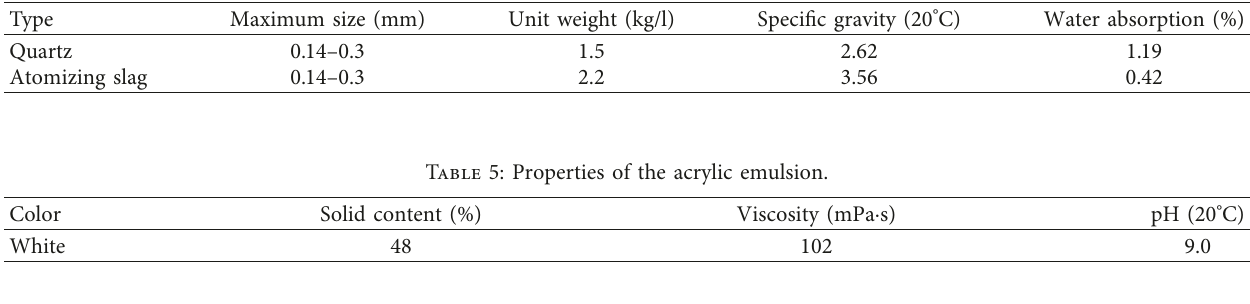
Table 4: Properties of the fine aggregates.